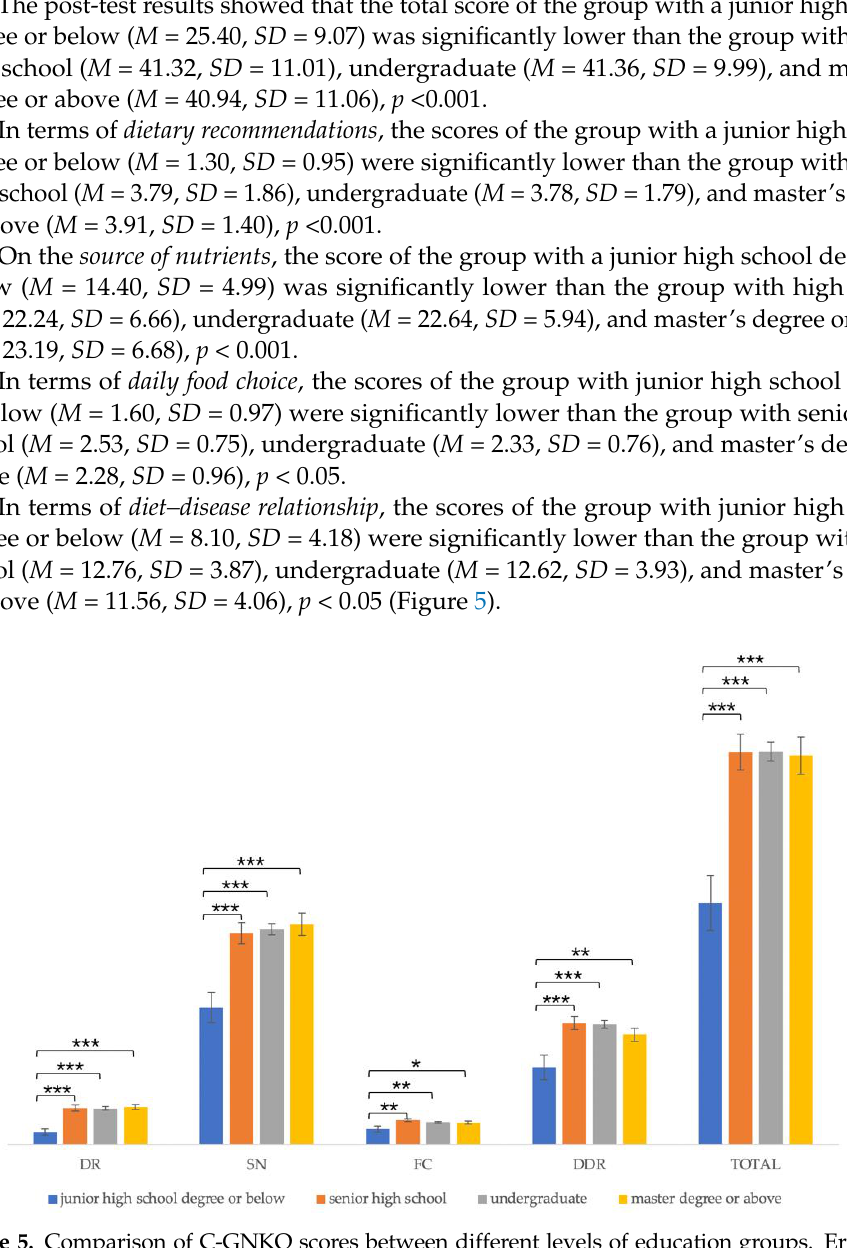
Figure 5. Comparison of C-GNKQ scores between different levels of education groups. Error bars represent standard errors. * indicates p < 0.05, ** indicates p < 0.01, and *** indicates p < 0.001. DR: